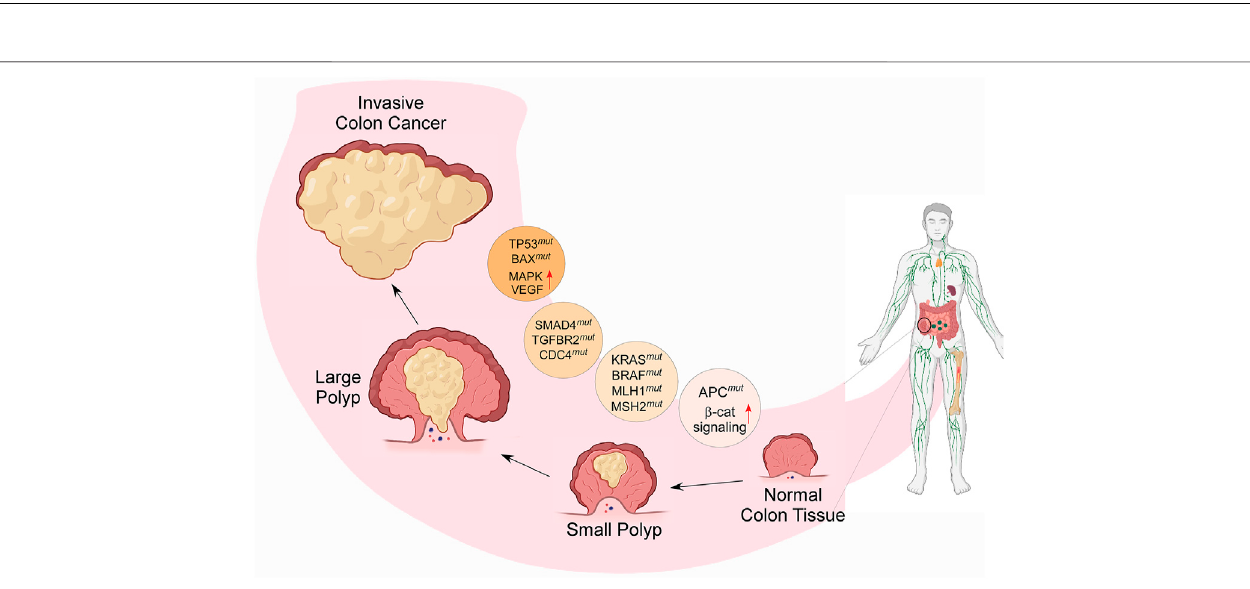
FIGURE 2 | Diagram representing the molecular cause of CRC and its gradual development from small adenoma polyp to invasive cancerous form; the process is modulated by several genetic modi fi cations, such as chromosomal instability; mutations in tumor suppressor genes and DNA mismatch repair genes, such as TP53 , MLH1 , MSH2 , SMAD4, TGFBR2 , CDC4; stimulation of oncogenic signaling pathways, such as K-RAS, BRAF, MAPK; and activation of the growth factors, such as COX2, EGF & VEGF- mediated signaling. ( β -cat (cid:1) β -catenin, mut (cid:1)